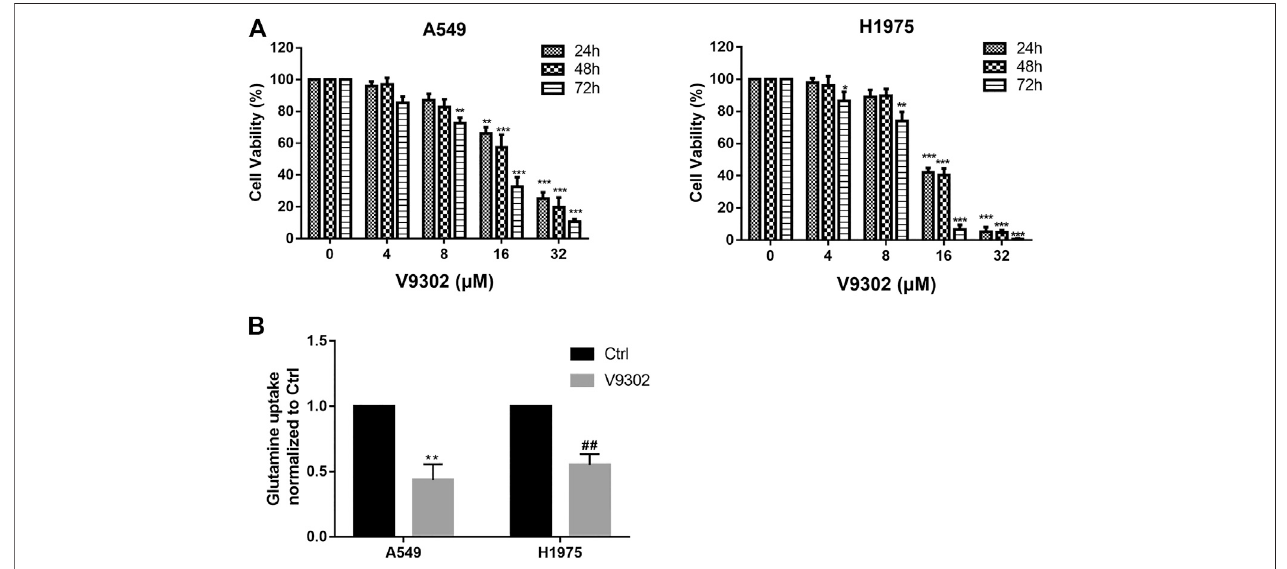
FIGURE 3 | Effects of SLC1A5 inhibition or knockdown on cell proliferation and glutamine uptake in NSCLC cells. (A) CCK8 assay was used to detect different concentrations of V9302 on H1975 and A549 cells for 24, 48 and 72 h. (B) Inhibition SLC1A5 or knockdown of SLC1A5 can reduce the uptake of glutamine in NSCLC cells. Signi fi cance: * p < 0.05, ** p < 0.01,*** p < 0.001, ## p <